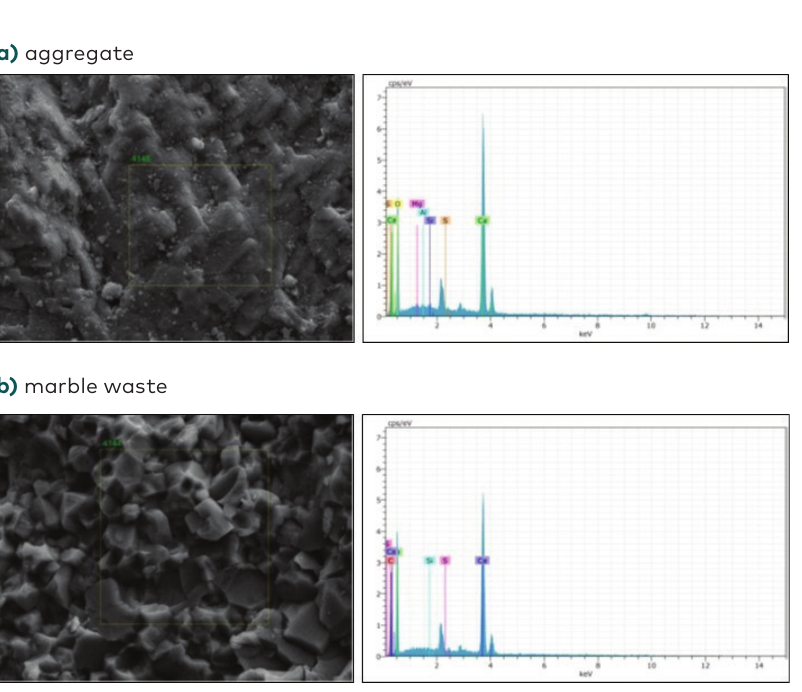
Figure 7. EDS image and graphic of materials: a) aggregate; b)